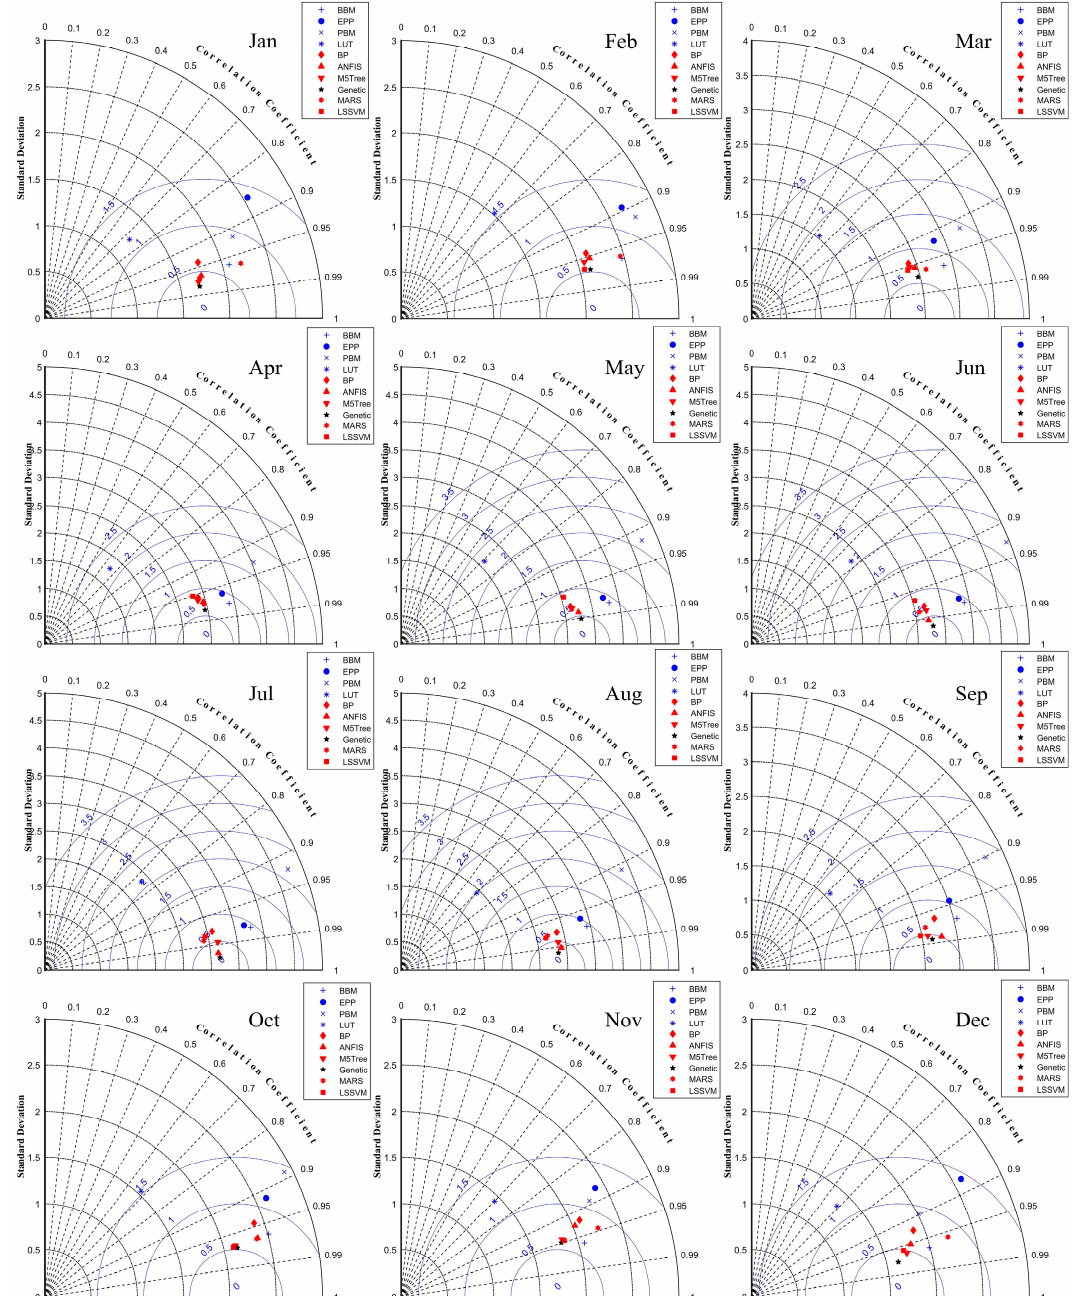
Figure 6. Monthly variations of the statistical indicators representing the model accuracy.